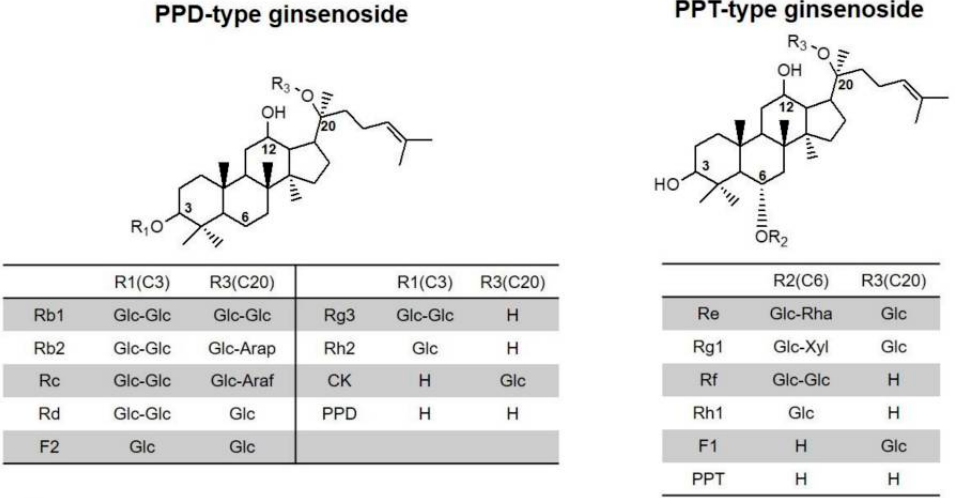
Figure 1. Structure of main ginsenoside types: 20(S)-protopanaxadiol (PPD) and 20(S)-protopanaxatriol (PPT). Reprinted from [26] with permission (CC-BY from MDPI). Sugar residues: Glc: glucose; Arap: arabinopyranose; Araf: arabinofuranose; Rha: rhamnose; Xyl: xylose.